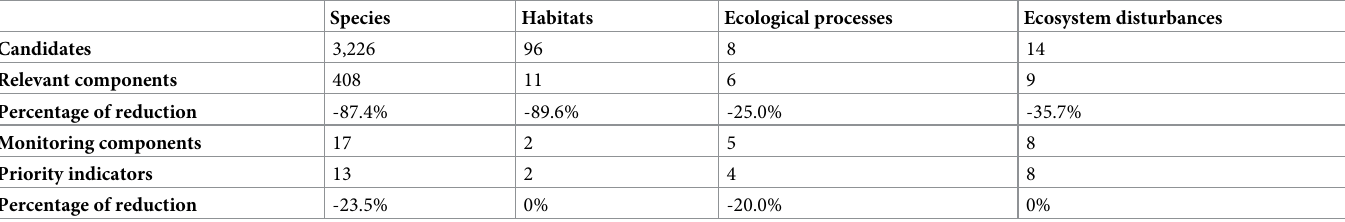
Table 4. Reduction in the number and percentage of candidates to relevant components through the use of the relevance index; and reduction of the number and percentage of monitoring components to priority indicators by a quantitative priority index. Species Habitats Ecological processes Ecosystem